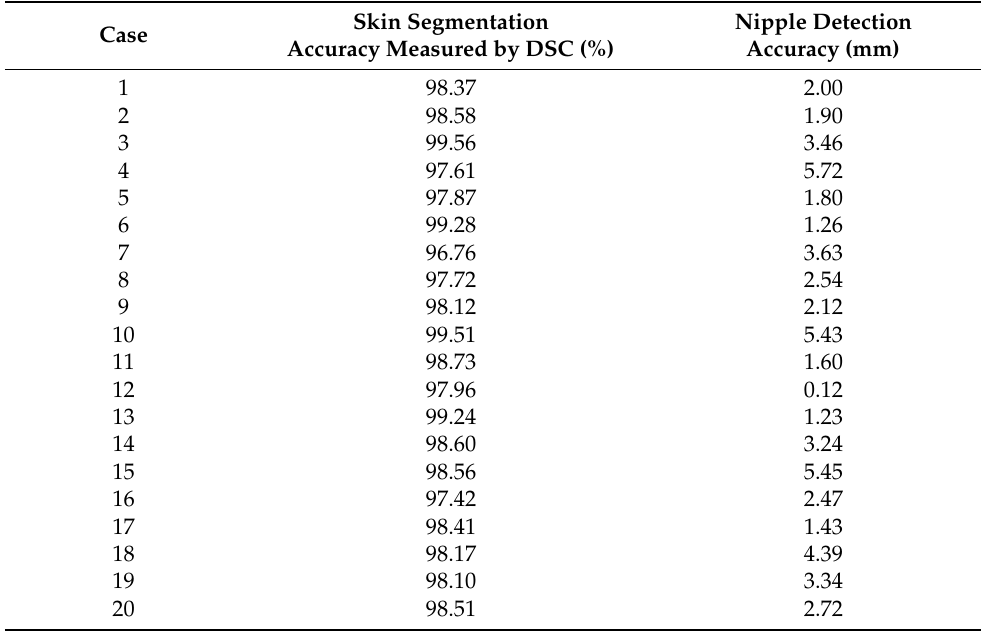
Table 1. Accuracy of skin segmentation and nipple